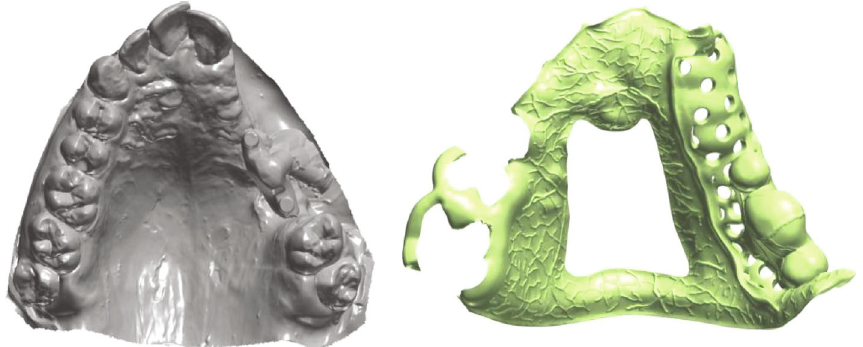
Figure 7: .STL fi le of the scanned cast and designing of cast partial denture.